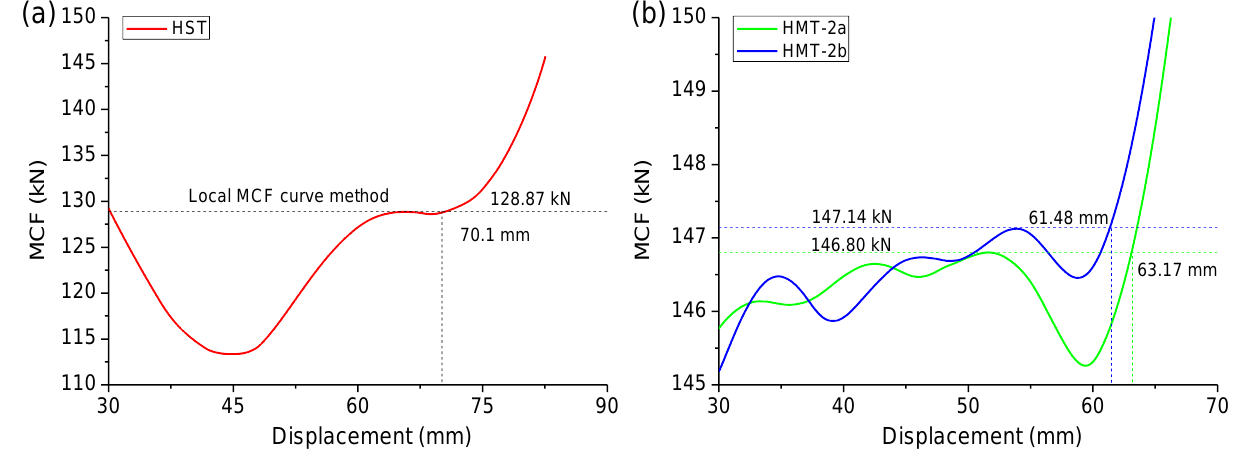
Figure 7. Local MCF curve of ( a ) HST and ( b ) HMTs to determine the MCF and the effective crushing distance.